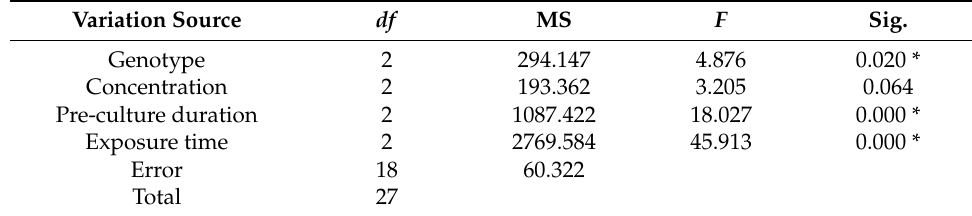
Table 4. The variation analyses of survival rates for different genotype leaves ( Liquidambar styraciflua × L. formosana ), concentration, pre-culture duration and exposure time.